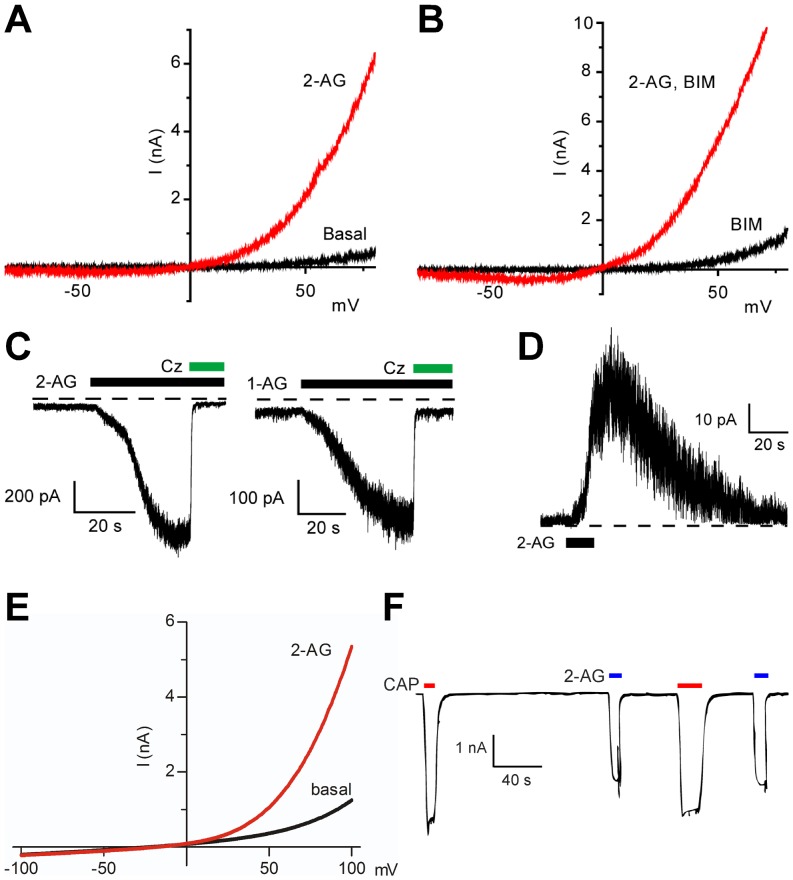
2-Arachidonoylglycerol and 1-arachidonoylglycerol activate heterologously expressed rat and human TRPV1.Current-voltage relationships after application of vehicle (Basal) or 2-arachidonoylglycerol (2-AG, 10 µM) to rat TRPV1-expressing CHO cells in the absence (A) and presence (B) of the protein kinase C inhibitor bisindoylmaleimide IV (BIM; 10 µM). Each current-voltage curve is representative of 3 cells. (C) Current traces showing responses to 10 µM 2-AG (left) and 10 µM 1-arachidonoyl glycerol (1-AG, right) in rat TRPV1-expressing CHO cells at a holding potential of −60 mV. Application of 10 µM of the TRPV1 antagonist capsazepine (Cz) immediately reversed the inward currents. (D) Excised inside-out patches from rat TRPV1-expressing CHO cells responded to 10 µM 2-AG with robust outward currents at a membrane potential of +60 mV. (E) Current-voltage relationships before and after application of 2-AG (10 µM) in HEK293 cells stably expressing human TRPV1. (F) Inward currents in HEK293 cells transiently expressing human TRPV1 at a holding potential of −50 mV. Traces show inward currents elicited by 2 µM capsaicin (CAP) and 10 µM 2-AG in a calcium free solution. Exposure to capsaicin and 2-AG a second time produced currents of similar magnitude. Data are presented as mean ± s.e.m. Kruskal-Wallis one-way ANOVA followed by Dunn's post hoc test was used for comparing groups of data. **P<0.01, ***P<0.001.